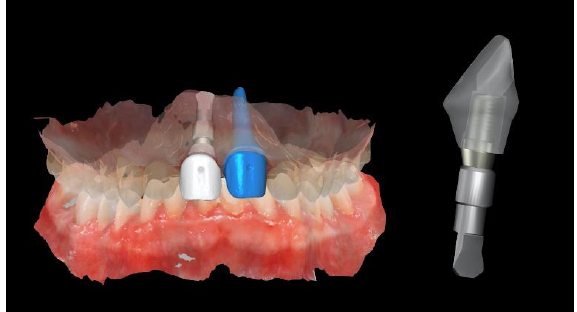
Figure 11. Intraoral digital impressions.